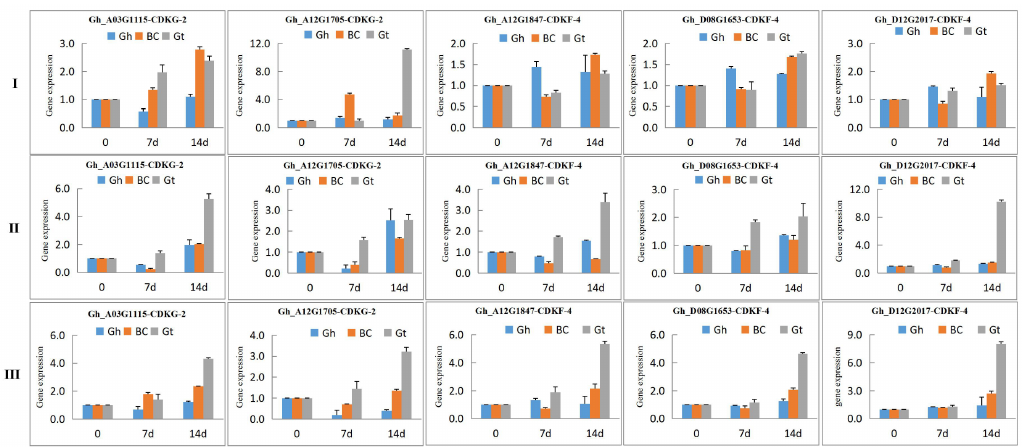
Figure 6. RT-qPCR expression profile of the top five highly expressed CDK genes in RNA sequences as compared to control with expression value 1.0 in upland cotton under drought stress. Gh: Gossypium hirsutum , BC: BC 2 F 1 generation, Gt: Gossypium tomentosum . 0, 7 and 14 are days of drought stress exposure. I : Expression on leaf tissue; II : Expression on stem tissue and III : Expression on root tissue.